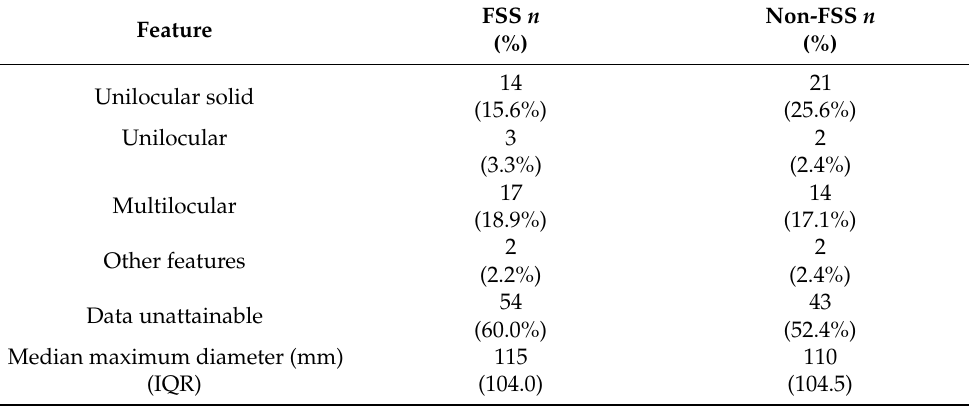
Table 1. Ultrasonographic features at diagnosis.